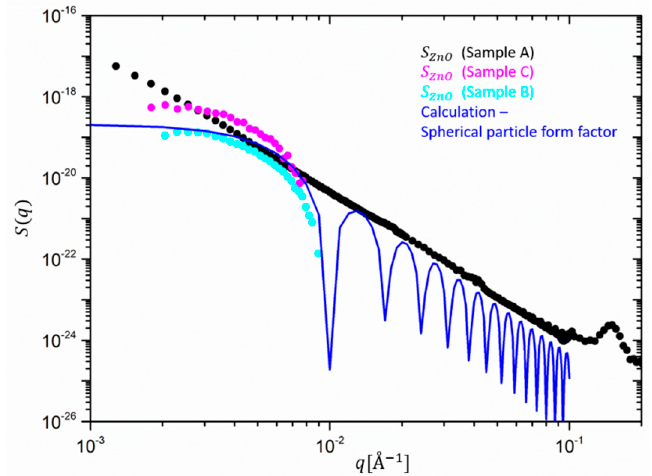
Figure 6. Partial structure factors for ZnO extracted from sample A (black), B (cyan), and C (magenta), and theoretical calculation of a spherical particle form factor (blue line).